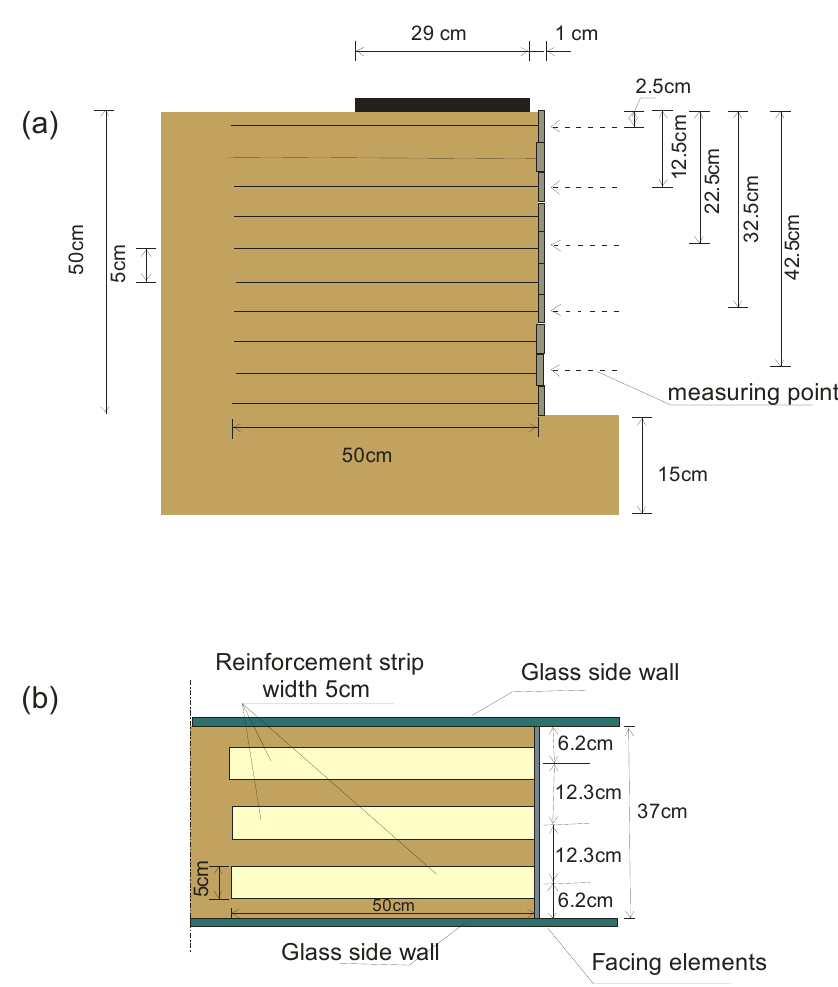
Figure 5. Stress-elongation behavior of the material used as reinforcement.